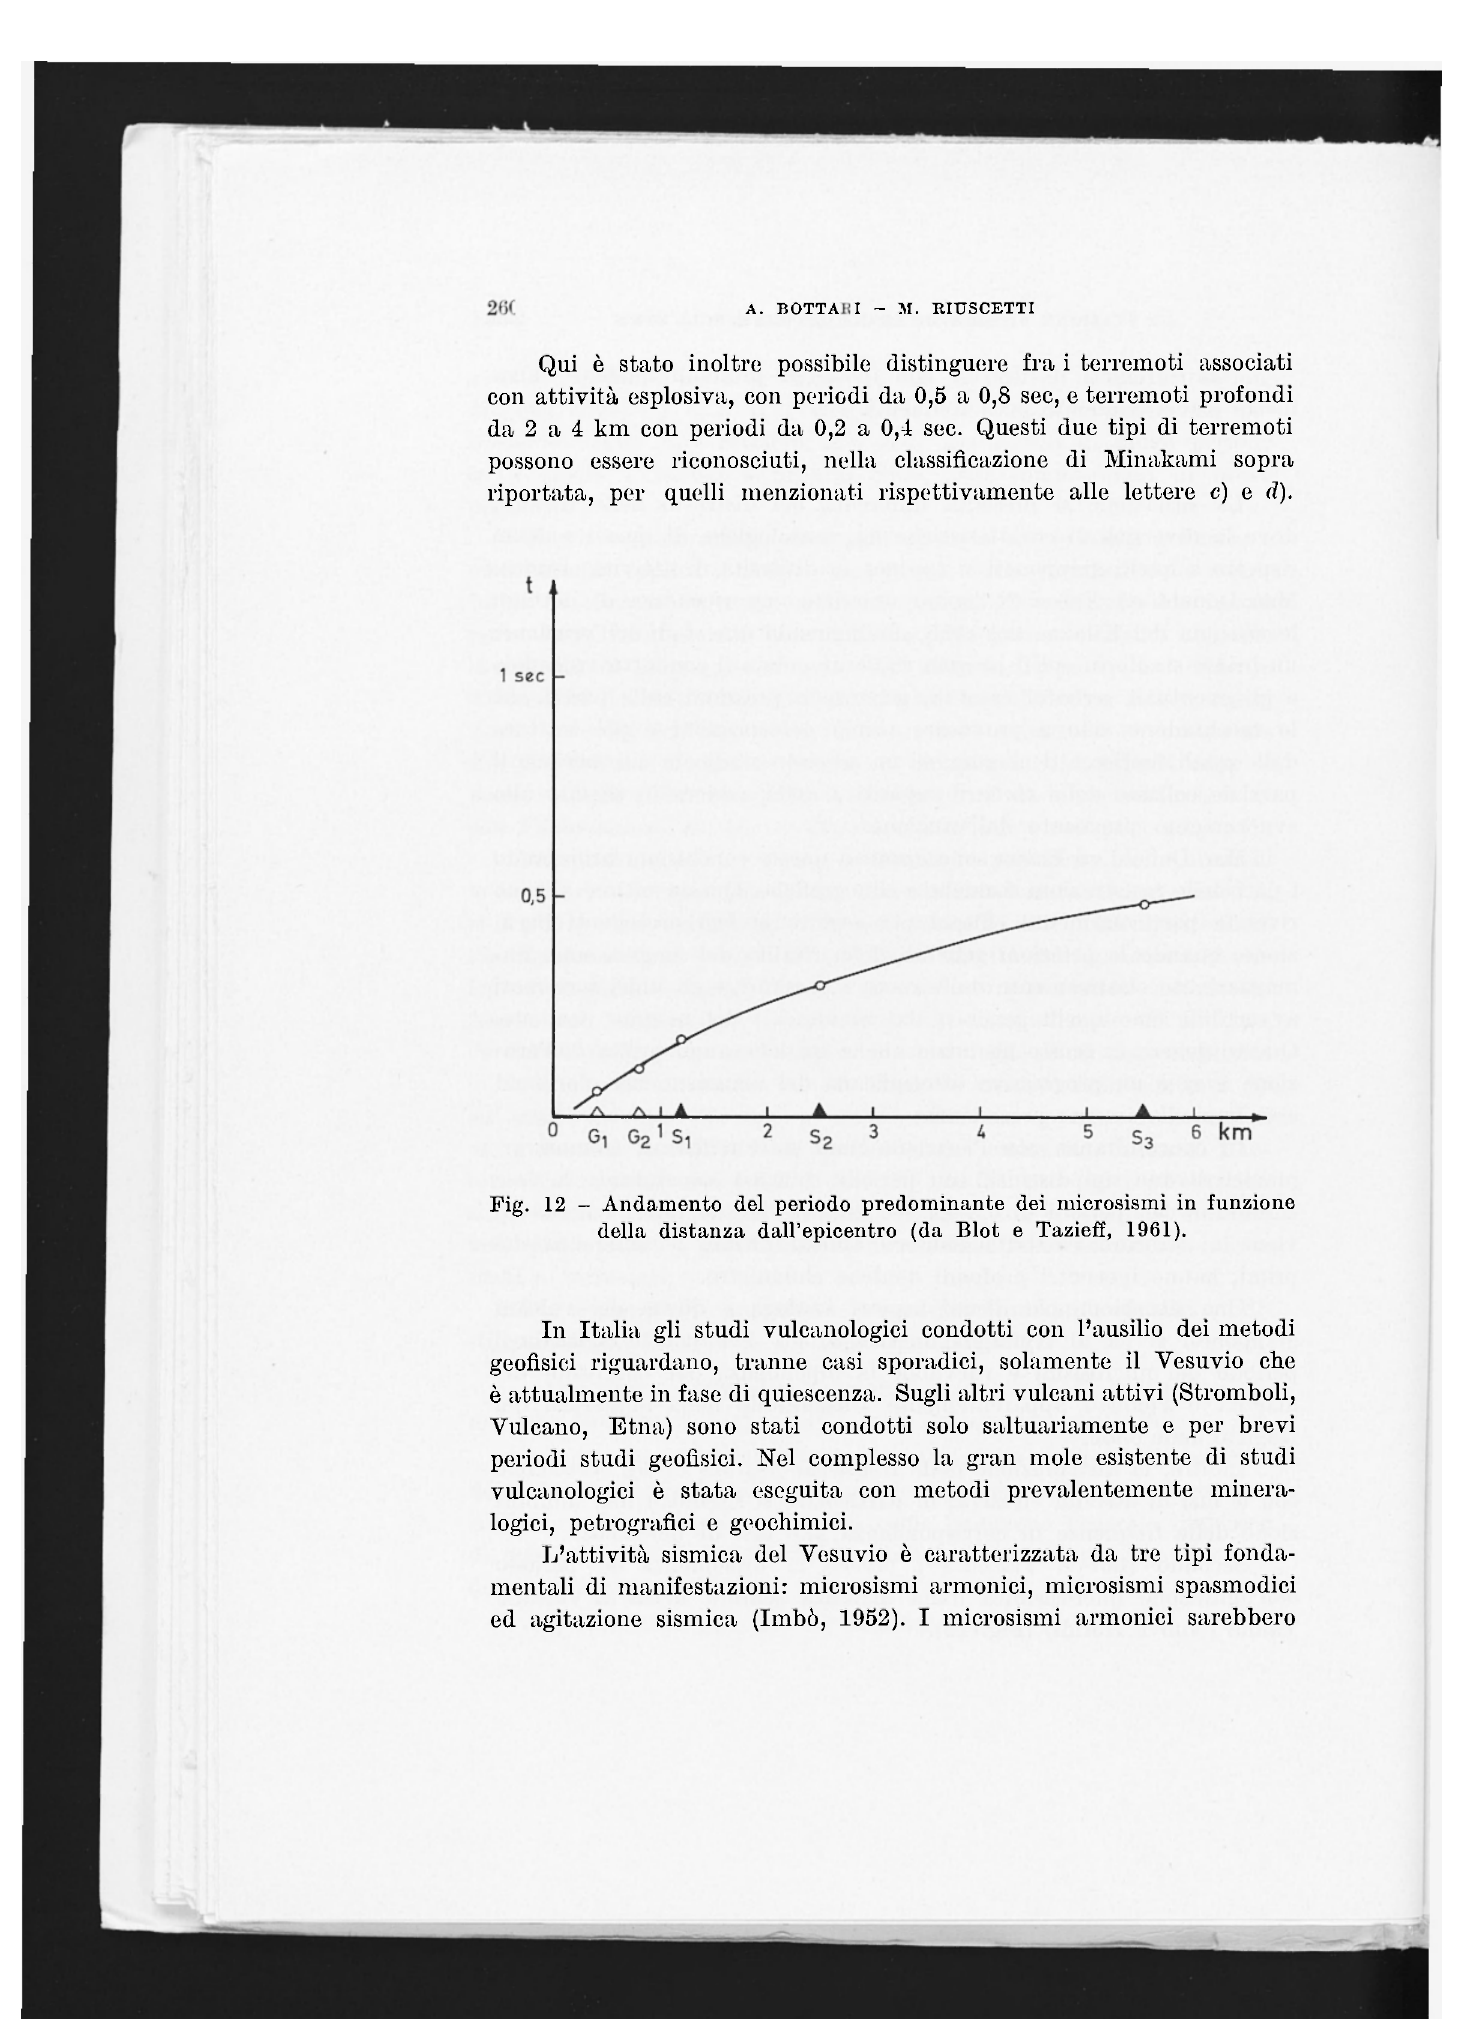
Fig. 12 - Andamento del periodo predominante dei microsismi in funziono della distanza dall'epicentro (da Blot e Tazieff,